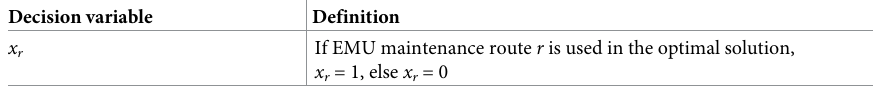
Table 3. Decision variable symbol